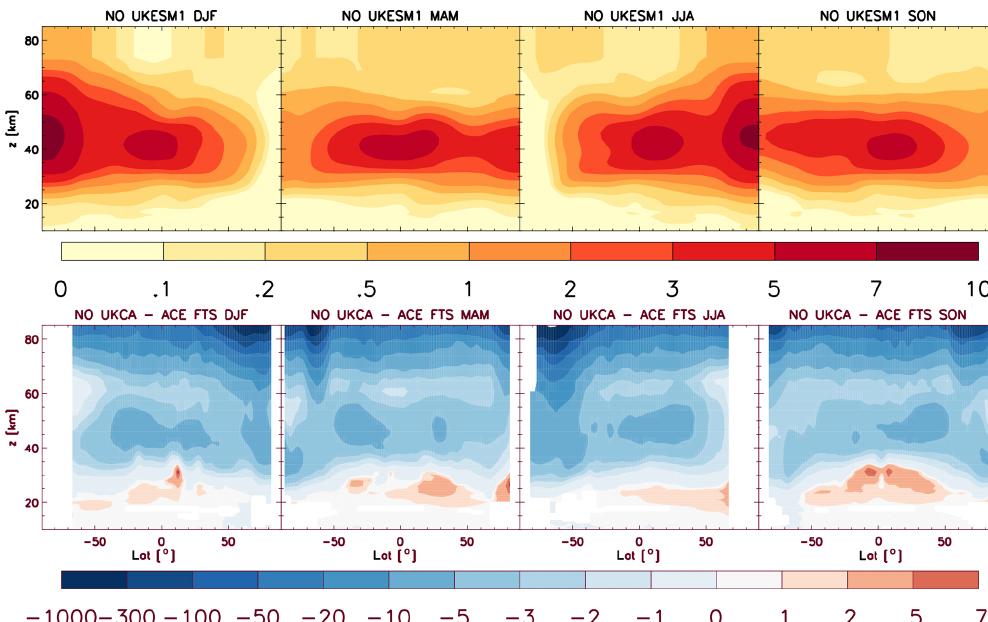
Figure 20. Zonal annual, seasonal annual, and multi-annual mean nitric oxide (NO) volume mixing ratio in parts per billion. Top row: UKCA StratTrop, February 2004 to February 2013. Bottom row: bias versus the ACE-FTS v3.5 climatology, with the same units and period. The climatology represents the average of sunrise and sunset measurements, while the model values are averaged over all local times. The model data analysed are from the FR simulation.